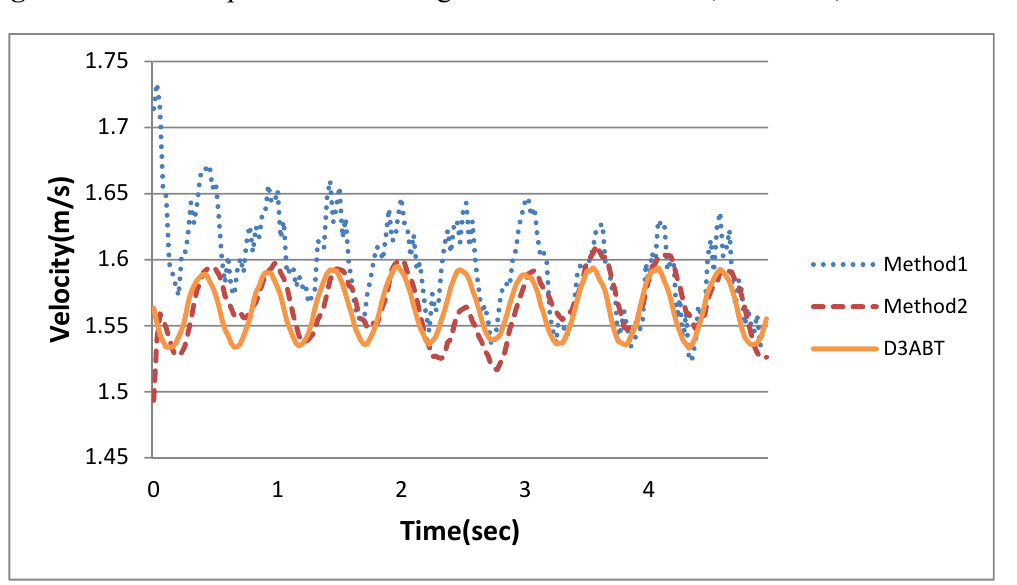
Figure 13. The comparison of walking velocities of D3ABT, Method1, and Method2.